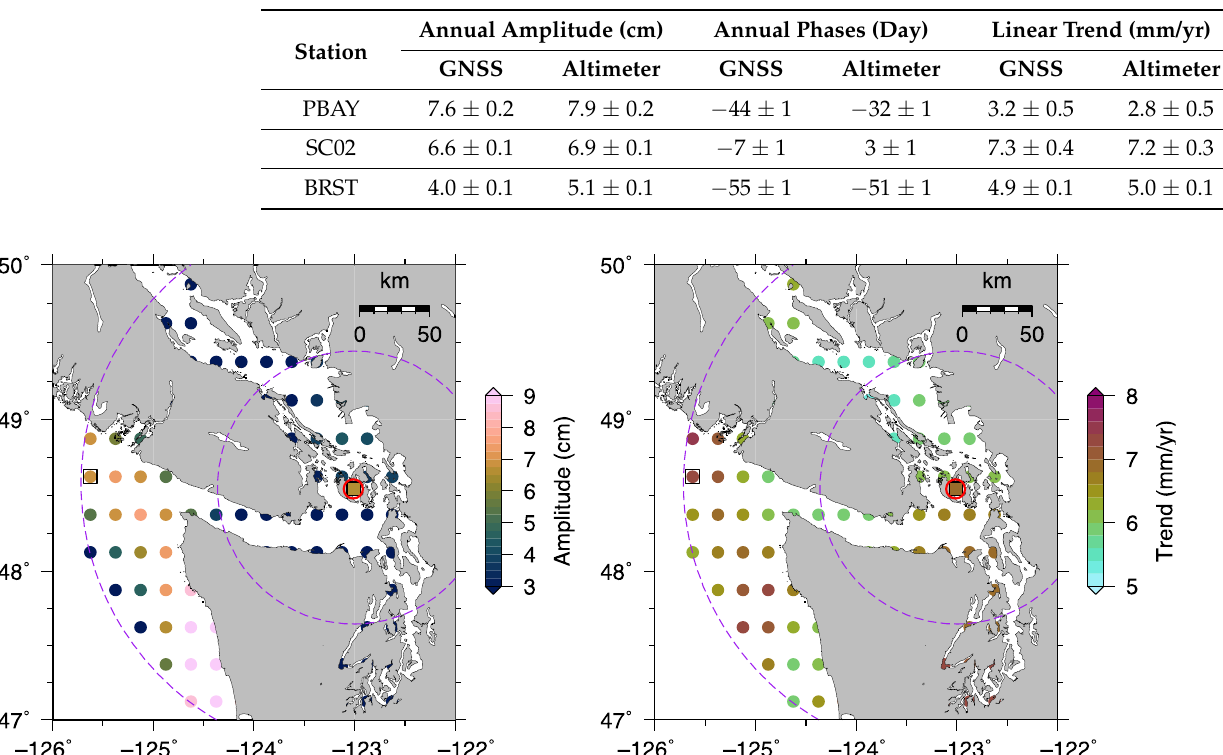
Figure 5. Annual amplitudes (left panel) and linear trends (right panel) estimated from the satellite altimeter data within 200 km from SC02. The purple dash lines are circles with radius of 100 km and 200 km from SC02.The filled square represents the GNSS station, and the open black circle is the tide gauge. The colored dot with a black square is the grid point from which the de-seasoned and de-trended satellite altimeter data has the highest correlation coefficient with those from the coastal